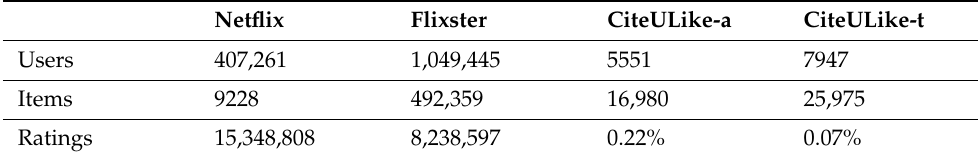
Table 1. Statistics of the selected